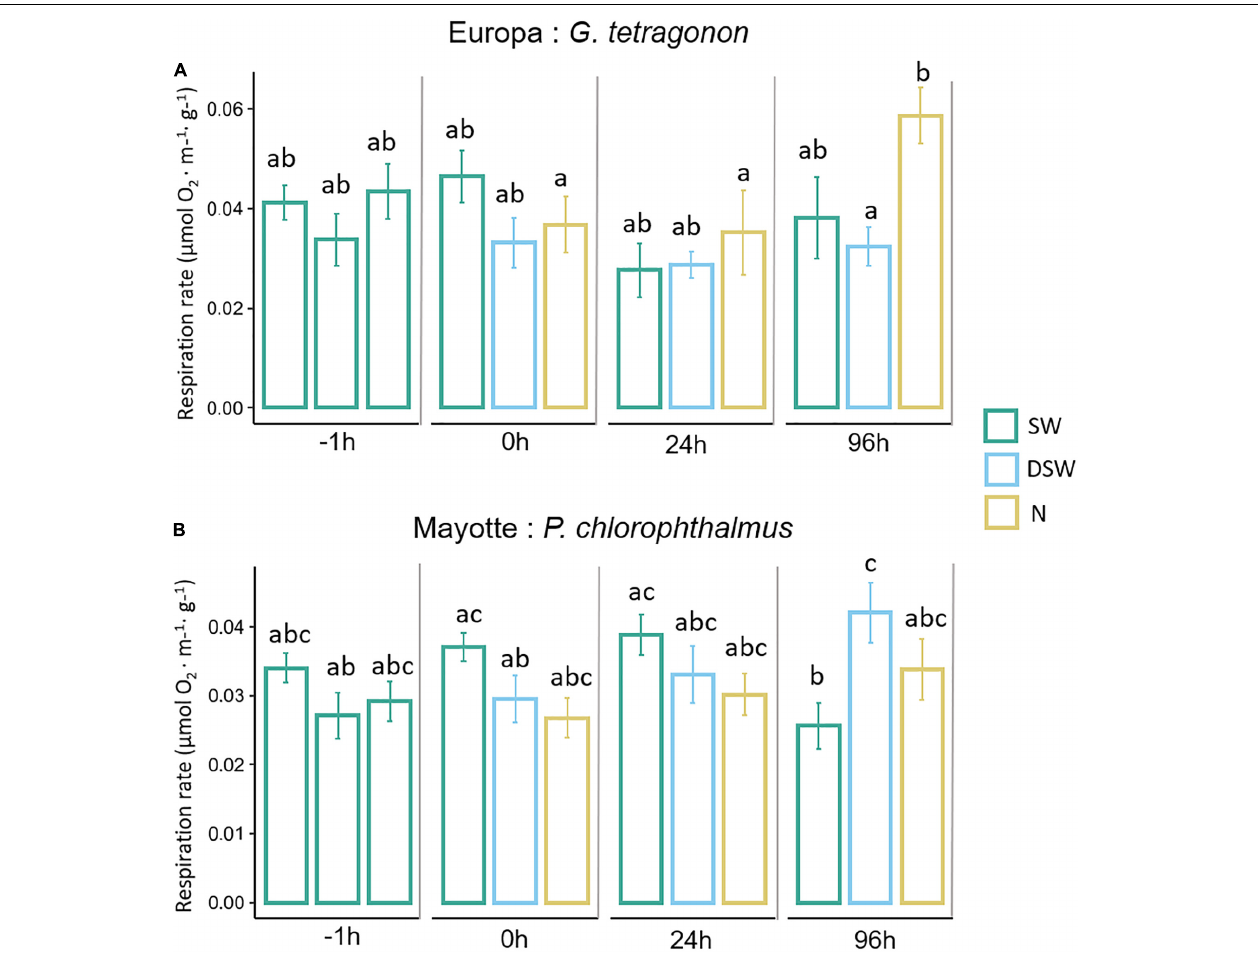
FIGURE 4 | Resting metabolic rate of GT (A) and PC (B) in SW, DSW and N at T-1h, T1h, T24h, and T96h exposure. Values are mean ± SE. Different letters indicate significant two-way interaction effects of treatment and time after Wald Chi-square test and pairwise multiple comparisons (Bonferroni